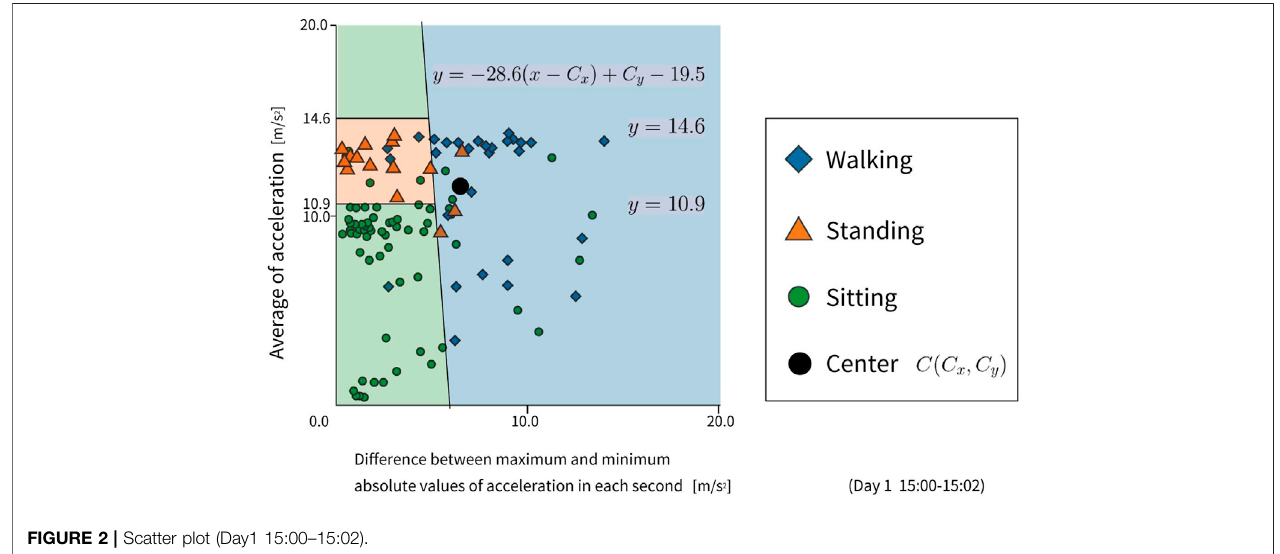
FIGURE 2 | Scatter plot (Day1 15:00 – 15:02).